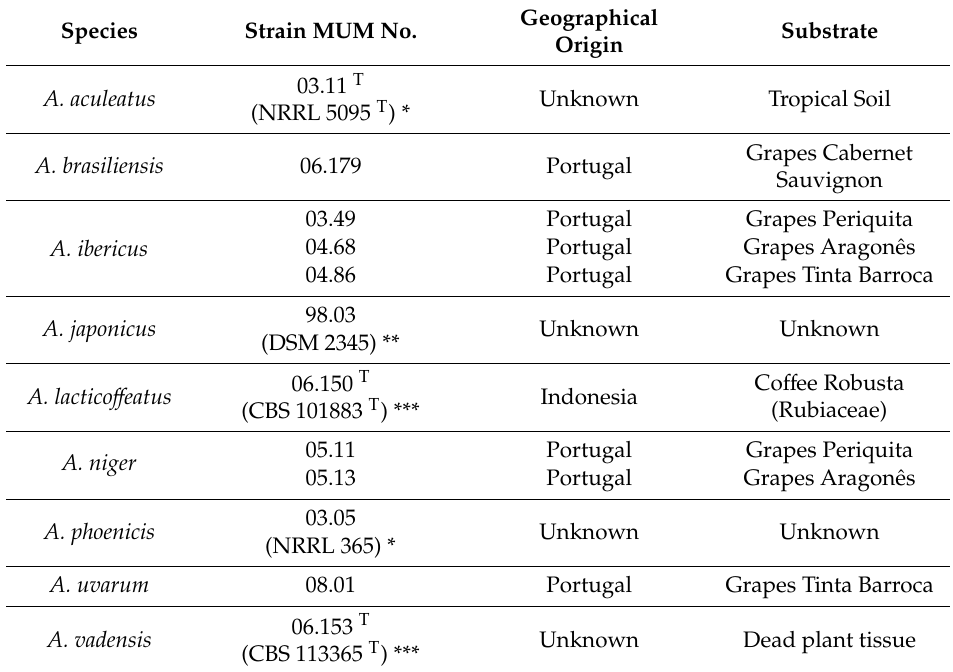
Table 1. Selected Aspergillus section Nigri strains and their associated